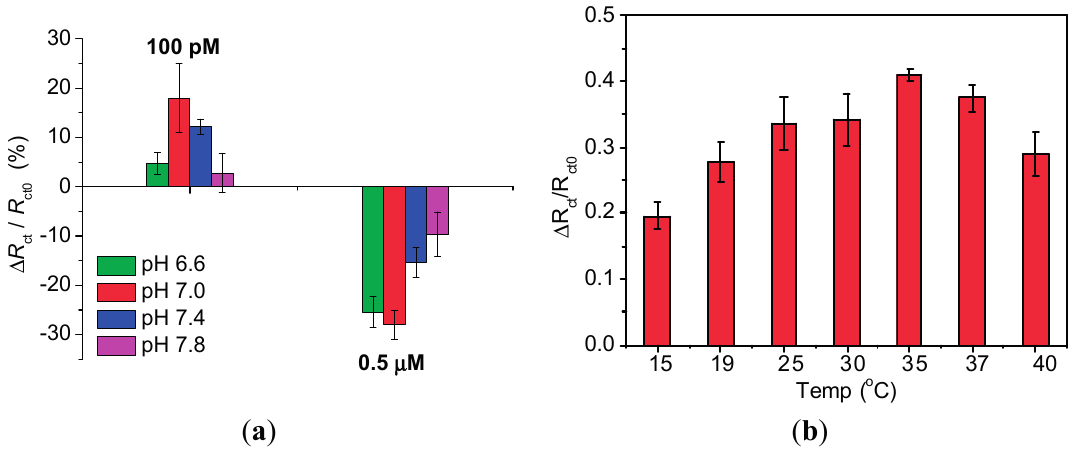
Figure 6. ( a ) Influence of buffer pH on electrochemical response of biosensor; influence of buffer pH was studied by interactions of aptasensor with two thrombin concentrations 100 pM and 0.5 µM. ( b ) Influence of incubation temperature on biosensor response studied by incubation of aptasensor with 0.5 µM